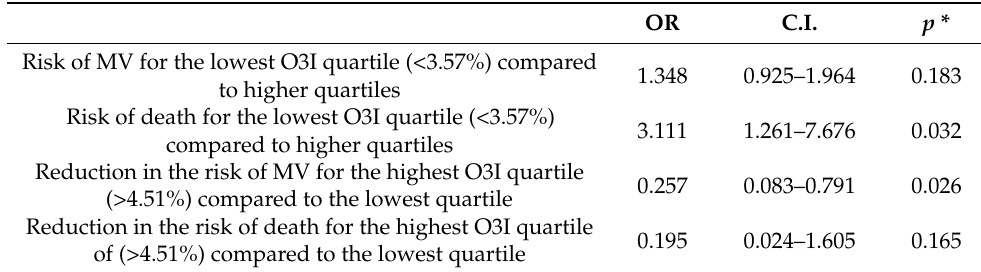
Table 4. Model of the associations of the Omega-3 Index with mechanical ventilation and death in the patients with severe